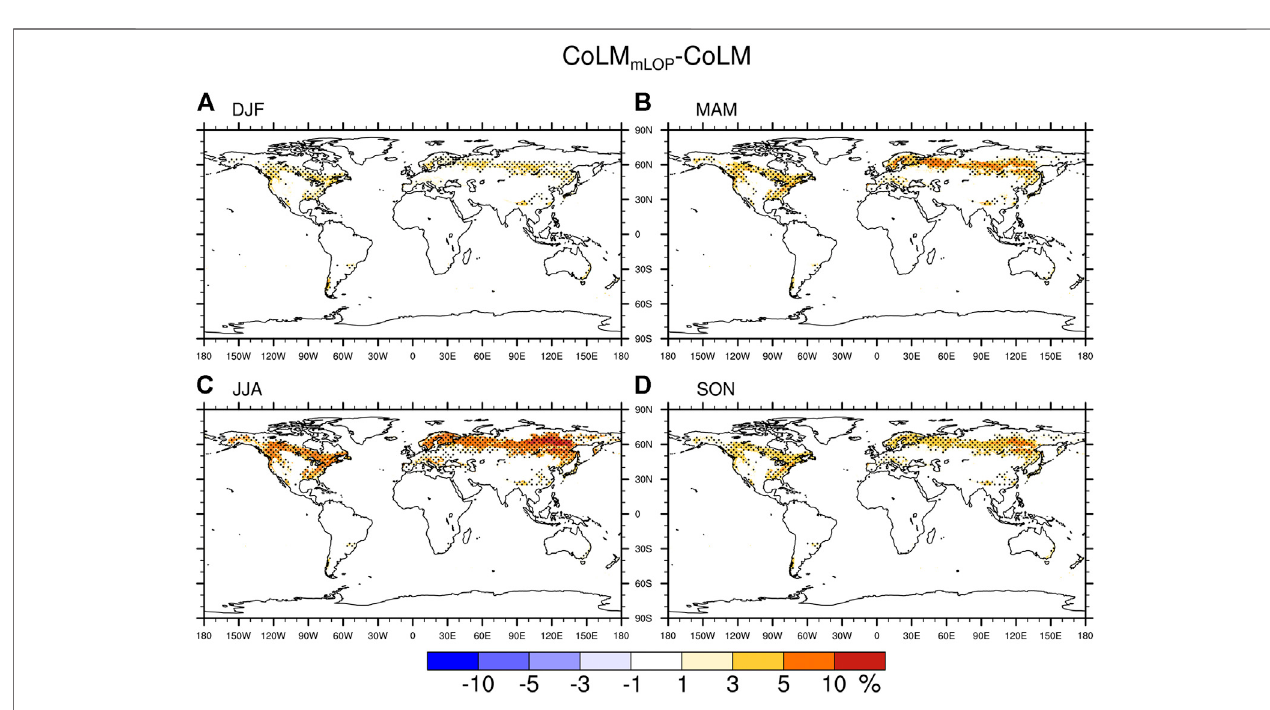
FIGURE 4 | Information the same as that in Figure 3 but for